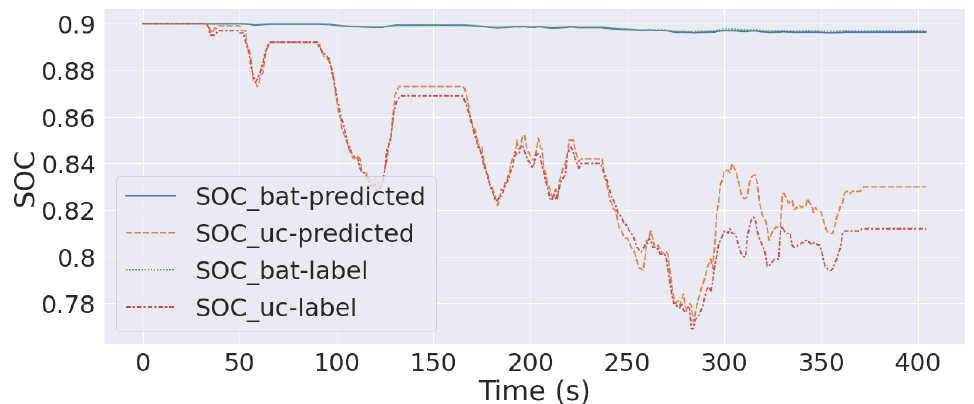
Figure 18. Comparison of the predicted and actual SOCs obtained by DRL when the initial SOCs are